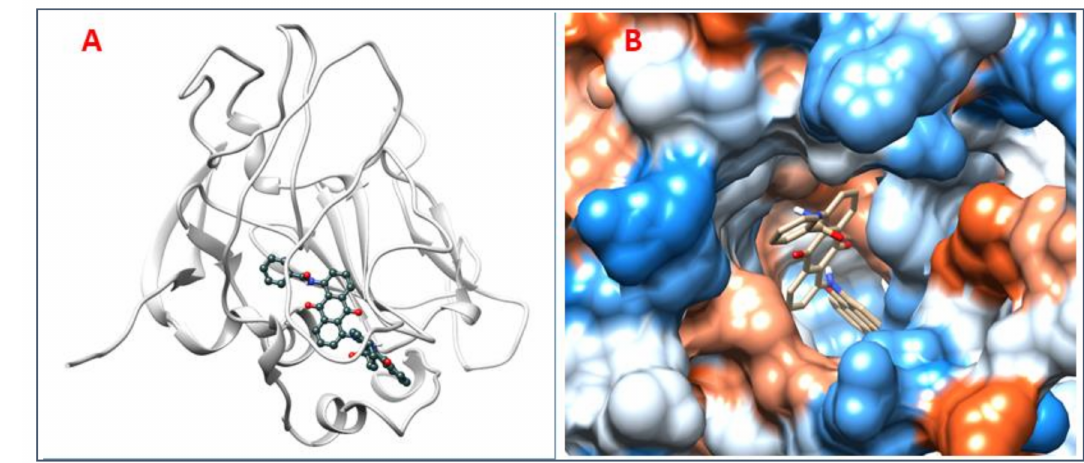
Figure 5. ( A ) 3D interaction of 2-[[5-[(4-ethylphenoxy)methyl]-4-prop-2-enyl-1,2,4-triazol-3-yl]sulfanyl]-N-[3-(trifluoromethyl) phenyl]acetamide and HCV E2 protein having binding affinity − 13.2. ( B ) Surface representation of interaction.